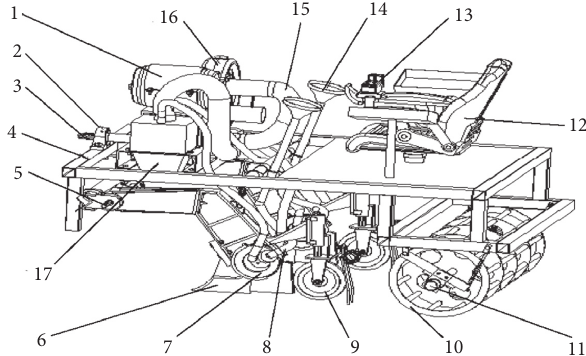
Figure 2: 3D drawing of seeder. (1) Air pump. (2) Bearing. (3) Power input shaft. (4) Frame. (5) Spline shaft. (6) Opener. (7) Seed metering device. (8) Guided seed tube. (9) Press wheel. (10) Land wheel. (11) Encoder. (12) Work platform. (13) Electromagnetic valve. (14) Aid seed funnel. (15) Vacuum tube. (16) Vacuum fan. (17) Waste seed recovery